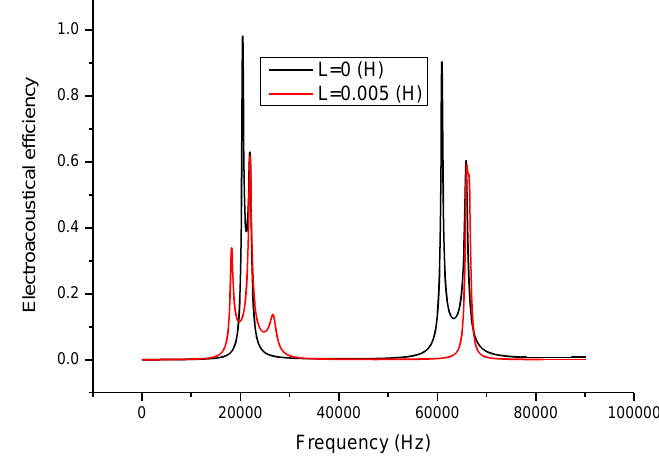
Figure 7. Frequency response of the electro-acoustical efficiency.